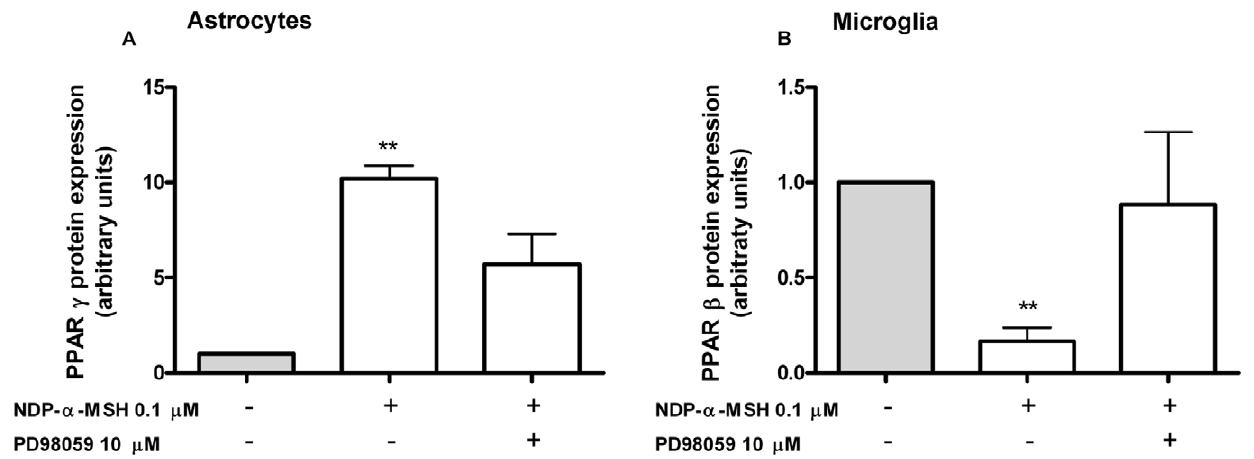
Figure 4. ERK-1/2 partially mediates the effect of NDP- a -MSH on PPAR expression. Cells were treated for 15 min with 10 m M PD98059 and then 0.1 m M NDP- a -MSH was added to the culture medium. Cells were harvested after 24 h of incubation and PPAR protein levels were assessed by western blot. (A) The effect of NDP- a -MSH over PPAR- c expression was not observed in the presence of PD98059 in astrocytes. (B) Similarly, the effect of NDP- a -MSH on PPAR- b levels was not observed in the presence of PD98059 in microglial cells. Data were analyzed by one sample t Test and are expressed as mean 6 SEM. ** p , 0.01 vs. control group.